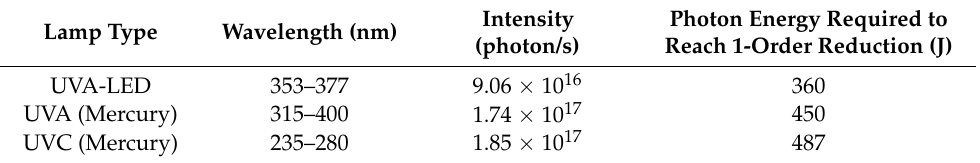
Table 1. Photon energy consumption in photocatalytic degradation of